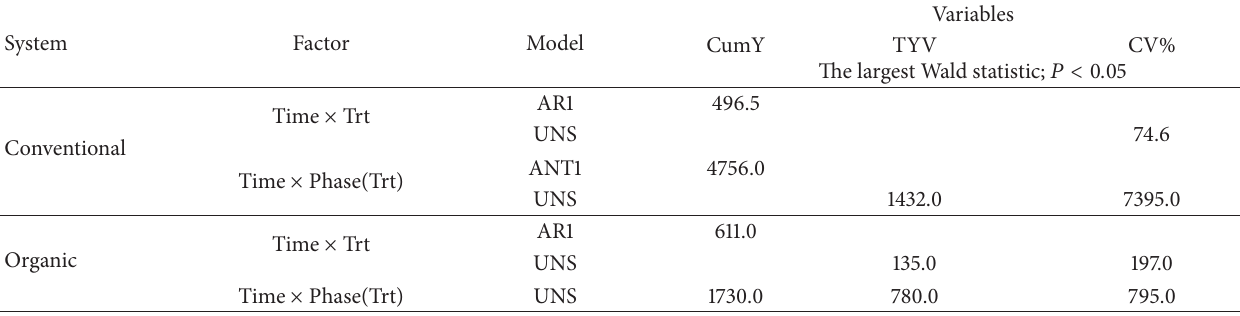
Table 8: Best covariance model based on the smallest deviance and the largest Wald statistic ( 𝑃 < 0.05 ) in repeated measures analyses of cumulative yield, CumY, temporal yield variance, TYV, and coefficient of variation, CV, to test for Time × Treatments (Time × Trt) interaction and Time × Phase within Treatments interaction (Time × Phase(Trt)) in conventional (CNV) and organic (ORG) cropping systems of a long- term